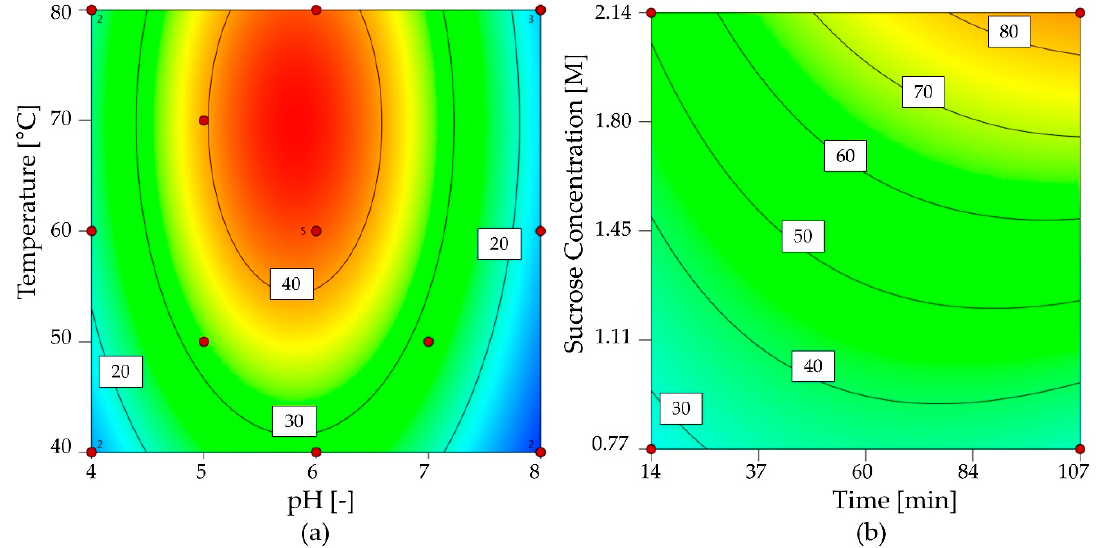
Figure 4. Contour plot of percentage FOS yield after catalysis with 1-FFT using a crude supernatant solution. ( a ) FOS yield as a function of pH and temperature (2 h reaction time, 1.75 M sucrose). ( b ) FOS yield as a function of time and sucrose concentration (pH 5.8, 70 °C).